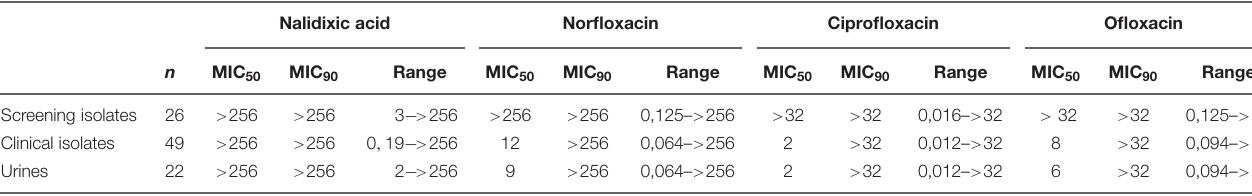
TABLE 1 | Fluoroquinolones MIC ( μ g/mL) among the clinical and the screening Enterobacter cloacae isolates.